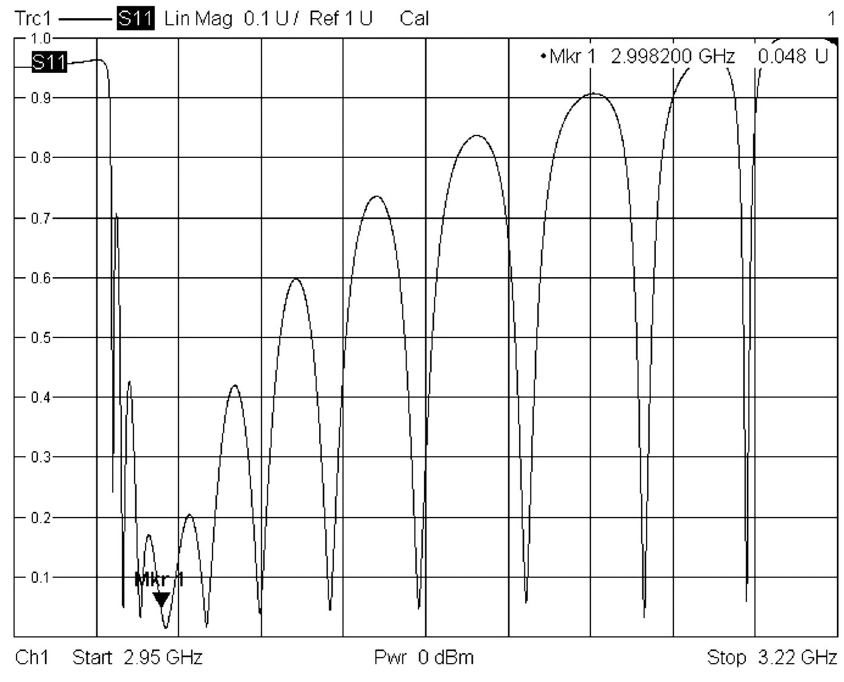
FIG. 17. Measured reflection coefficient at the input port.